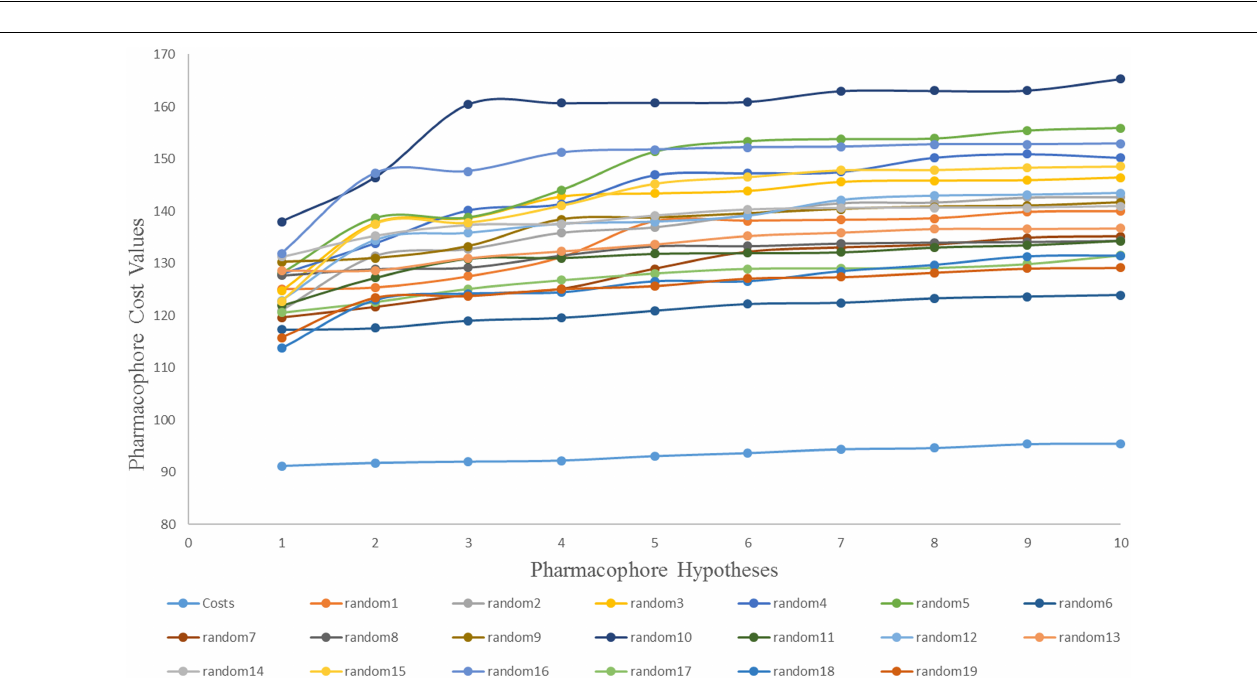
FIGURE 3 | Correlation between the experimented and predicted efficacies of the training set and the test set based on the Hypogen1 model.